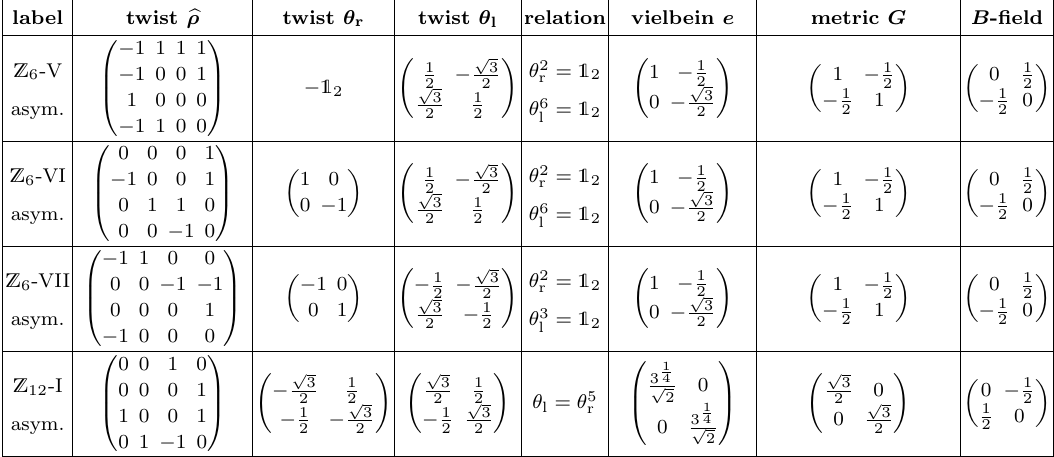
Table 3 : This table presents a large number of examples for Z K Narain orbifolds in two dimensions. For each inequivalent orbifold it gives important data that characterizes Narain orbifolds, like the twists in both, the lattice and the coordinate basis and the values of the (frozen)